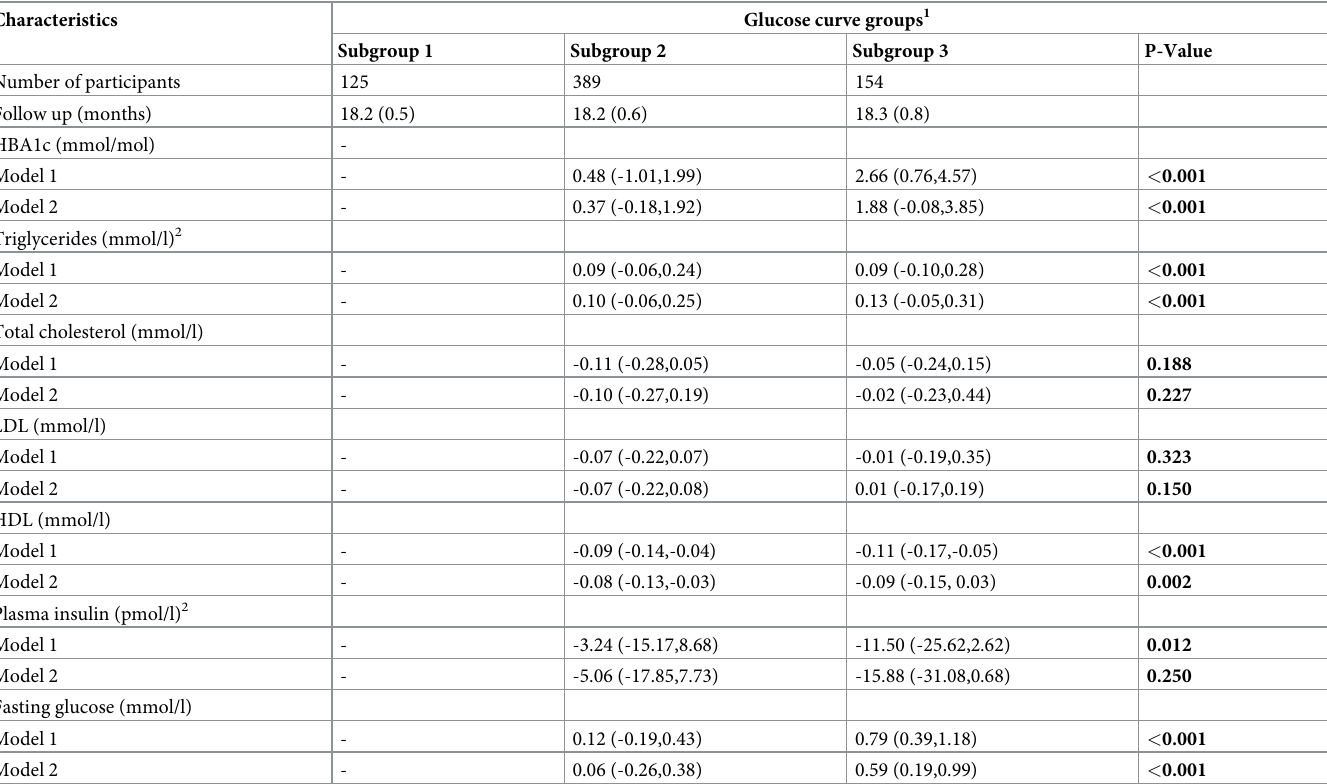
Table 3. Association between glucose curve groups and metabolic traits measured at 18 months in 668 individuals with type 2